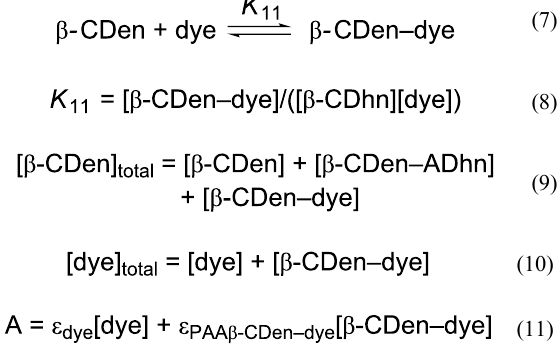
the dye complex at equilibrium, respectively. Given that [ β -CDen] total and [dye] total are the total concentrations; mass balances are given by Equation 9 and Equation 10. The UV–vis absorbance at a particular wavelength is given by Equation 11 where A , ε dye and ε PAA β -CDen–dye represent the observed absor- bance and molar absorbance of the dye and the host–guest com- plex, respectively. The K 11 (Table 2) were derived by best- fitting an algorithm based on Equations 1–3 and 7–11 to the UV–vis absorbance data using the HypSpec protocol [51,52].